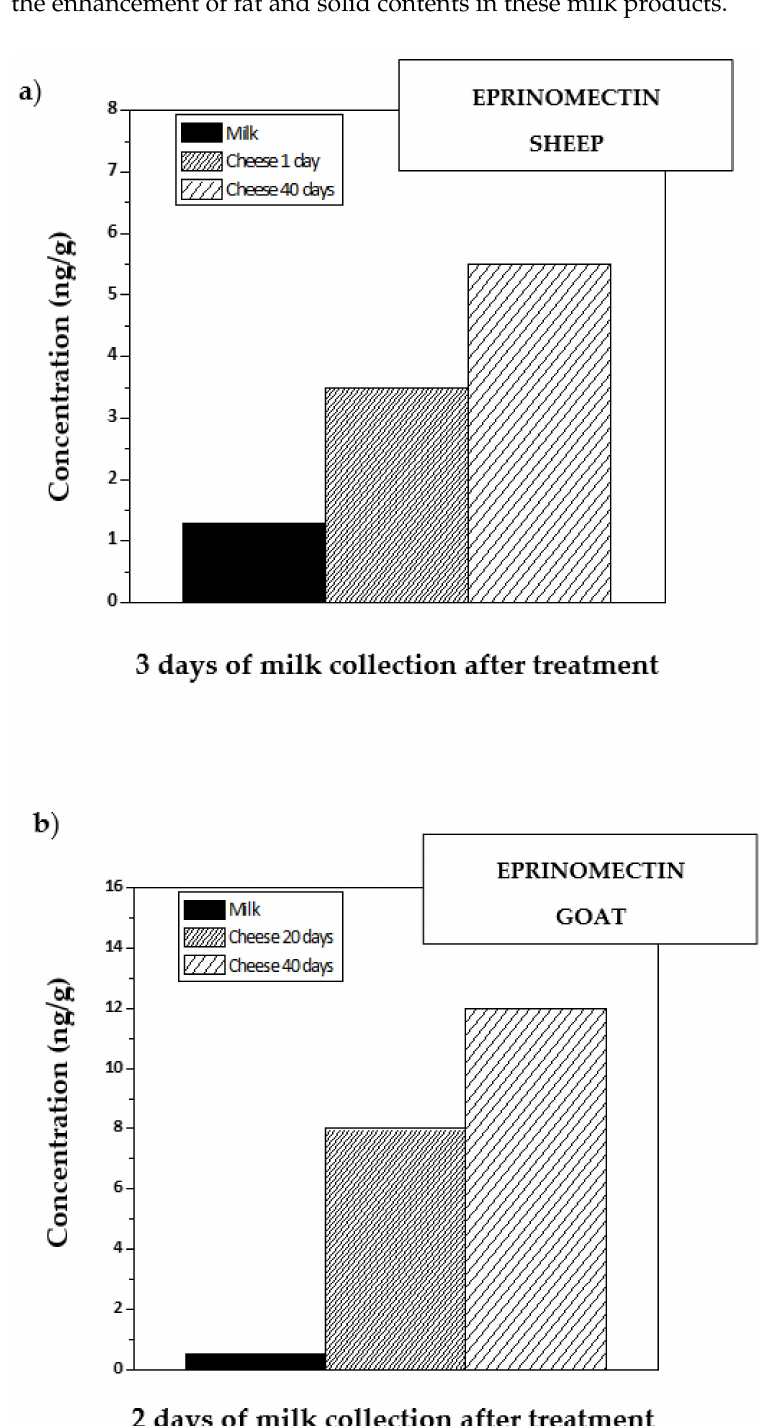
Figure 4. Comparative mean residual concentration of eprinomectin measured in cheese at different times of ripening (1, 20, and 40 days after elaboration) and milk collected 2 or 3 days after pour-on administration (0.5 mg/kg) in dairy sheep ( a ) and goats ( b ).The milk collected on day 2 or 3 was used to elaborate the cheeses. Source: Adapted from Imperiale et al. [82] ( a ) and Anastasio et al. [126] ( b